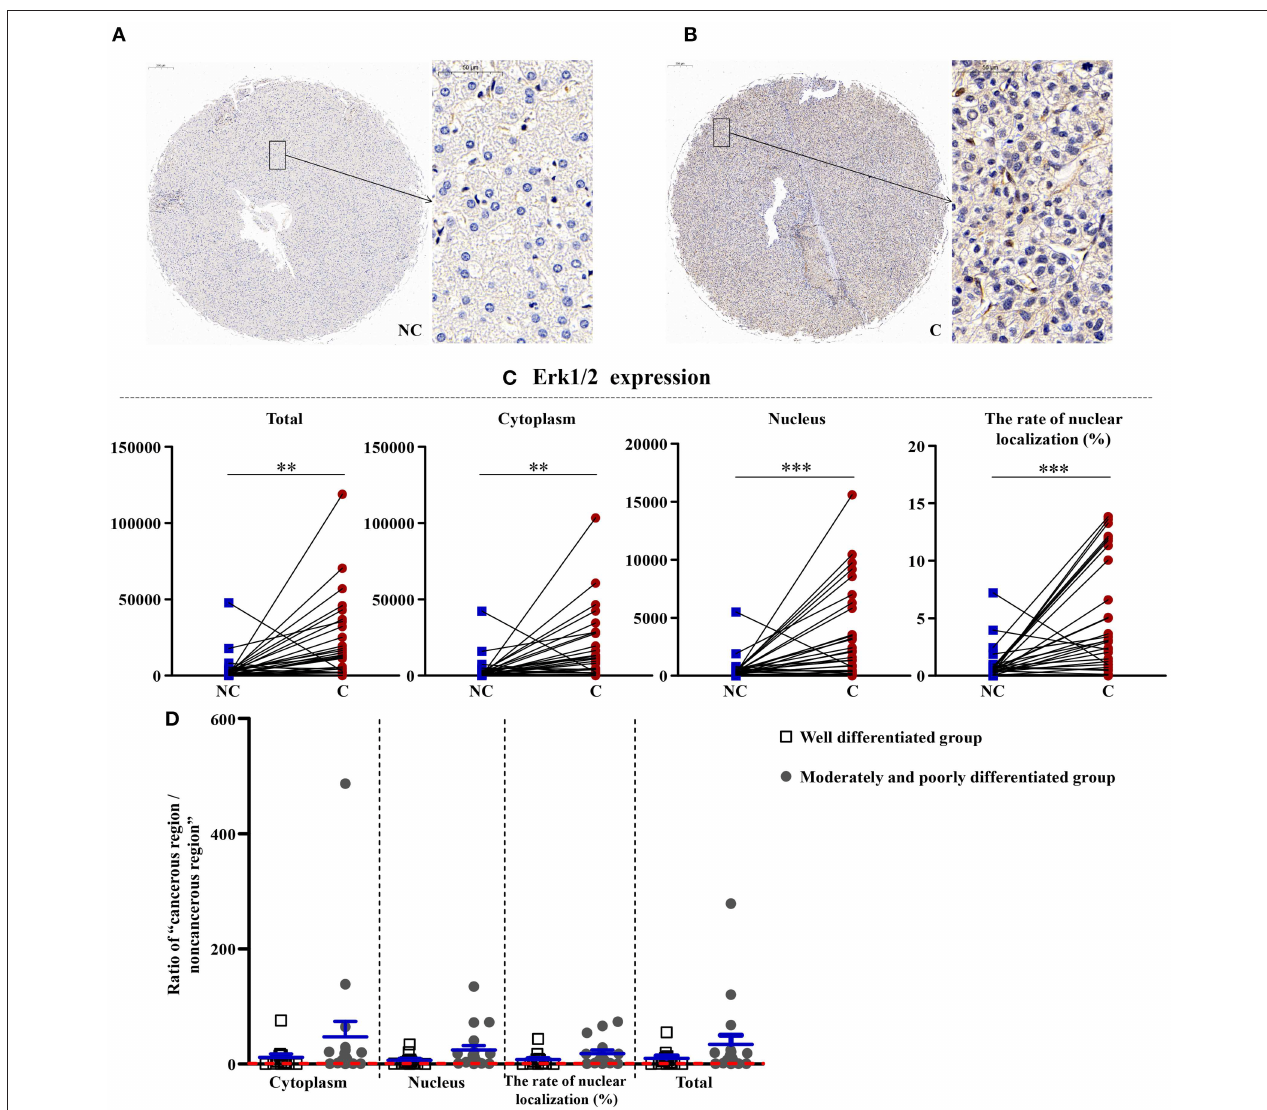
FIGURE 3 | The detailed expression of Erk1/2. Representative images of Erk1/2 protein expression in liver cancer’s corresponding (A) non-cancerous (NC) and (B) cancerous (C) regions. (C) Quantification of Erk1/2 expression (total, cytoplasmic, and nuclear expressions and the rate of nuclear localization) levels using multispectral image analysis in the liver cancer samples. (D) The ratio of “cancerous region/non-cancerous region” of Erk1/2 expression in two groups (well-differentiated group vs. moderately and poorly differentiated group). The red line indicates that the ratio is equal to 1. Scale bar: 200 or 50 µ m. ** , ***Denote significant differences from the well-differentiated group with P < 0.01, 0.001,